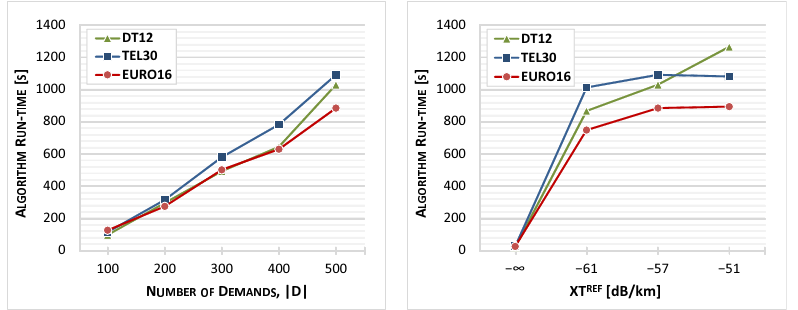
Figure 7. OSNR-LA-PSA computation times in a function of number of demands |D| for XT REF = − 57 dB/km (left chart) and reference crosstalk level XT REF for |D| = 500 (right